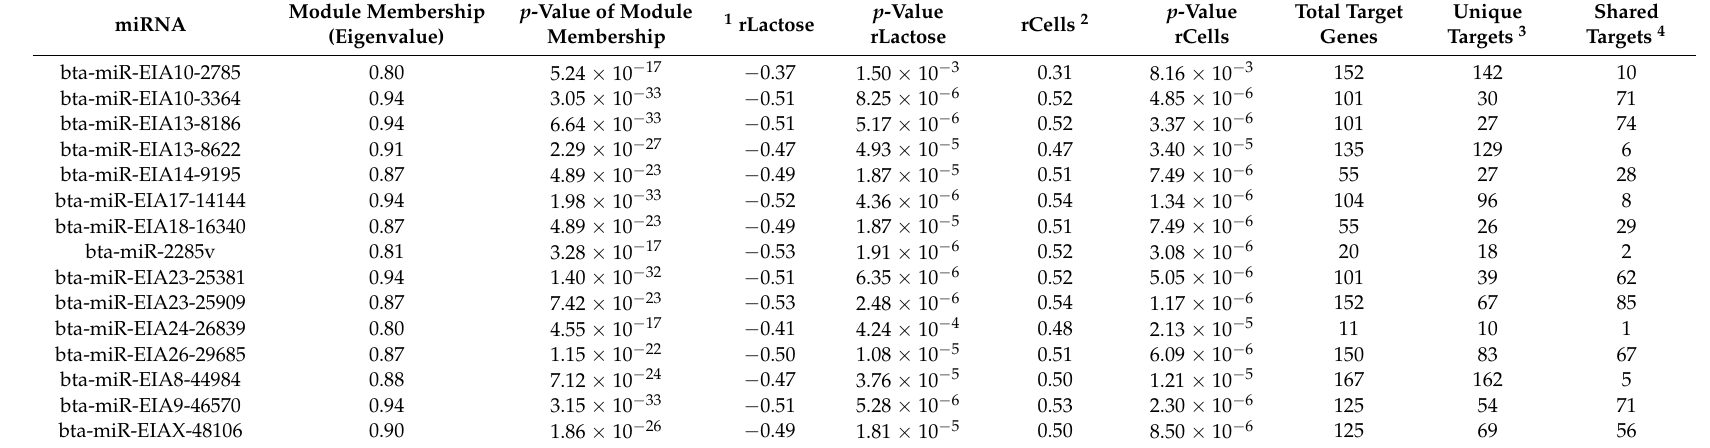
Table 4. miRNAs in the RED module, their correlation coefficients with lactose and somatic cell count, and predicted target genes